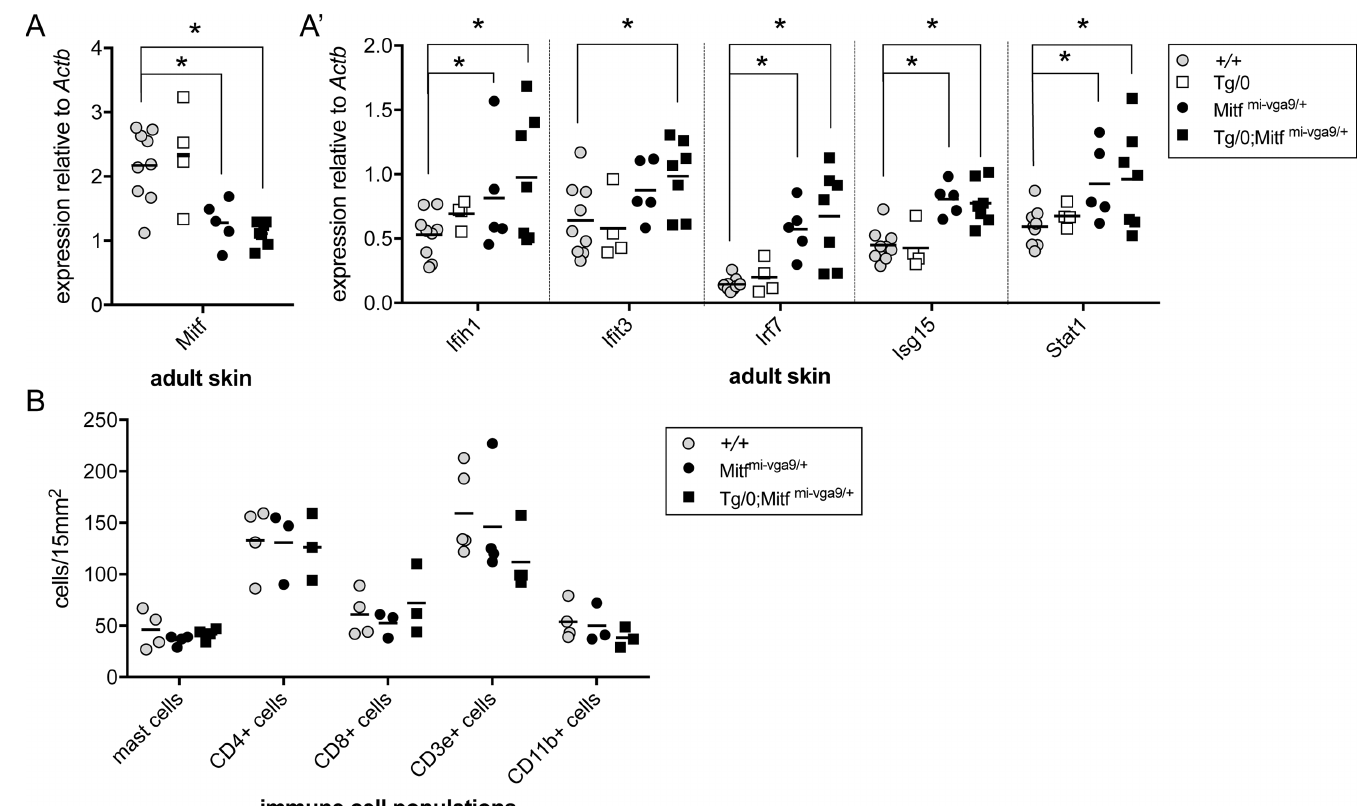
Fig 5. Mitf mi-vga9/+ and Tg(Dct-Sox10)/0; Mitf mi-vga9/+ animals exhibit elevated ISG expression but no change in the density of immune populations within the skin. (A, A 0 ) qRT-PCR analysis of Mitf and ISG expression in skin isolated from adult wild-type, Tg(Dct-Sox10)/0, Mitf mi-vga9/+ , and Tg(Dct-Sox10)/0; Mitf mi-vga9/+ littermates. Each point on the graph represents the expression value from skin of an individual animal. The horizontal bars represent the mean, and the asterisks indicate gene expression changes with a q -value of < 0.05 using the two-stage linear step-up procedure of Benjamini, Krieger, and Yekutieli, with Q = 5%. (B) Number of immune-related cells per a 15 mm 2 area of skin from the same animals as described in (A) harvested at mid-anagen. Mast cells were detected using toluidine blue staining, and other immune cells were detected by immunofluorescence for the indicated markers. Representative images of histological sections used for cell counts are provided in S2 Fig . Each point on the graph represents cell counts from an individual animal, and the horizontal bar represents the mean. t tests confirmed no statistically significant differences in the density of immune cells when comparing wild-type animals to Mitf mi-vga9/+ or Tg(Dct-Sox10)/0; Mitf mi-vga9/+ animals. The raw data used to generate the graphs in (A), (A 0 ), and (B) are available in S1 Data . Actb , actin beta; CD, cluster of differentiation; ISG, IFN-stimulated gene; Mitf , melanogenesis associated transcription factor; qRT-PCR, quantitative reverse transcription polymerase chain